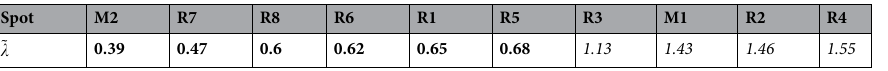
˜ (cid:31) ˜ (cid:31) < 1 . Values are